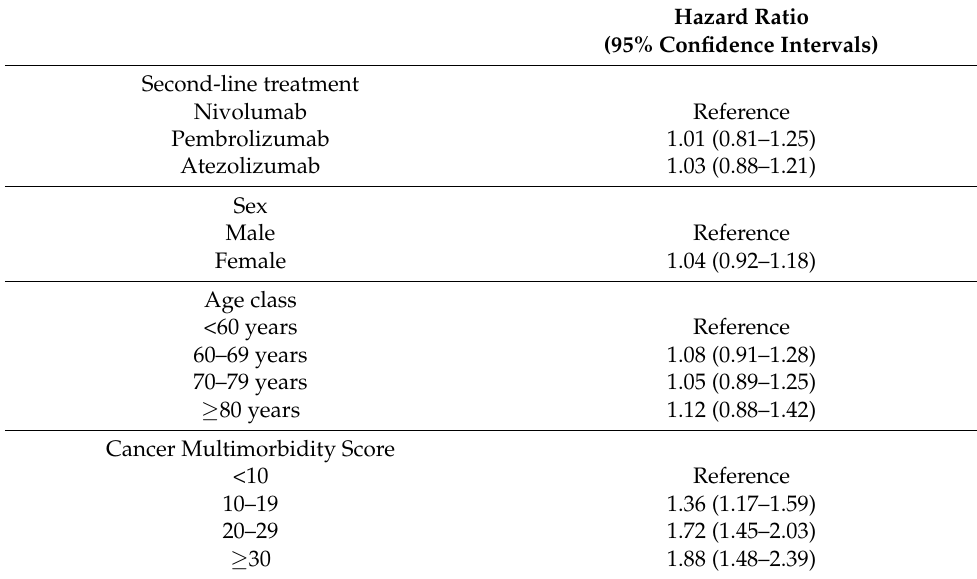
Figure 2. Two-year overall survival of 1607 advanced NSCLC patients starting a second-line systemic treatment with nivolumab, pembrolizumab and atezolizumab. Table 2. Association between selected covariates and risk of death among 1607 advanced NSCLC patients starting a second-line systemic treatment with immune checkpoint